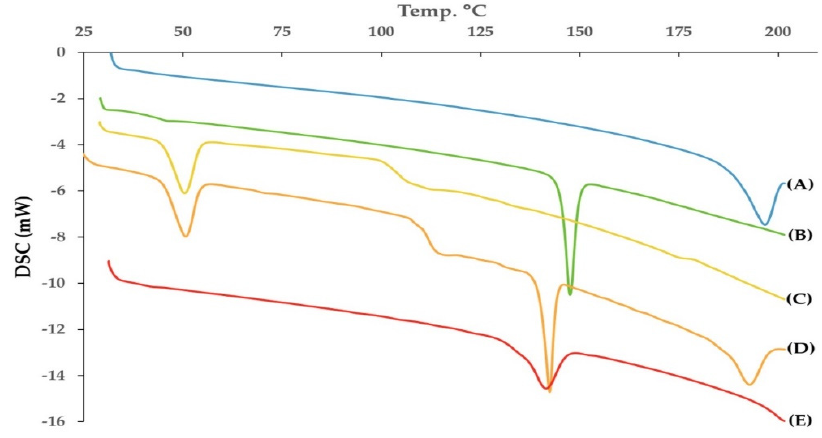
Figure 6. DSC thermogram of ( A ) pure Fexofenadine HCl, ( B ) Cholesterol, ( C ) span 40, ( D ) Physical mixture, ( E ) Optimized formulation powder.